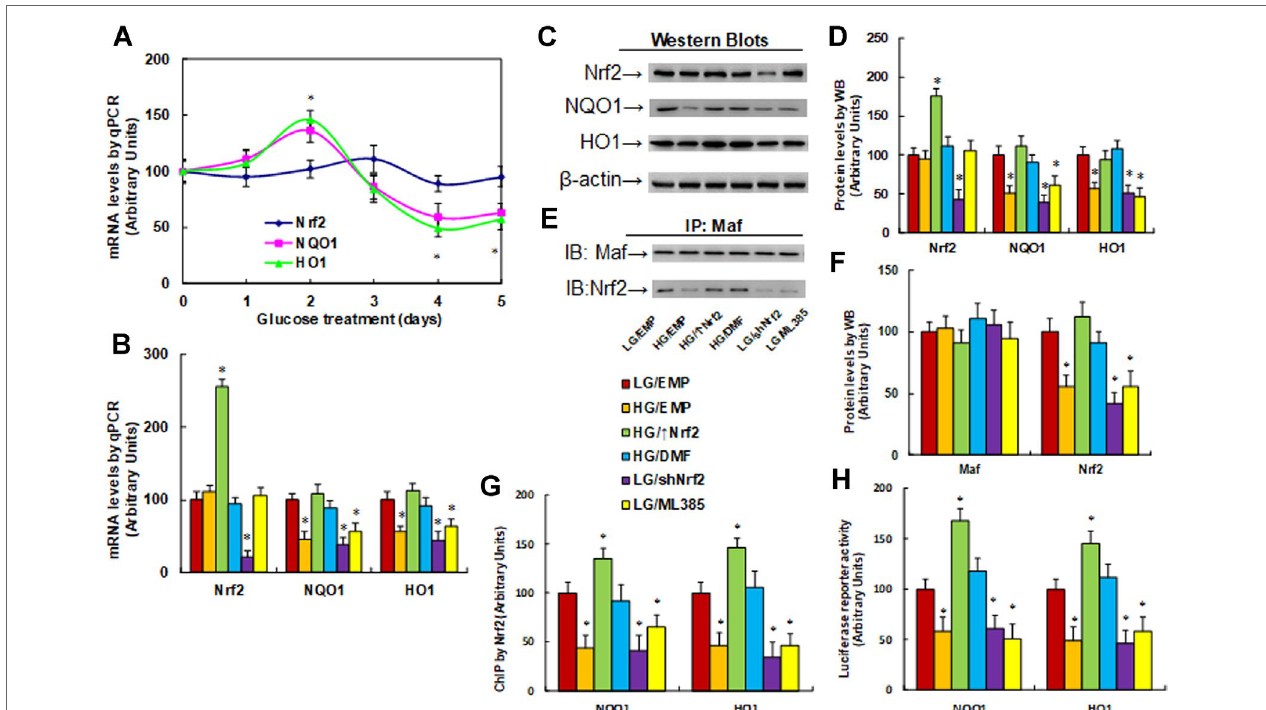
FIGURE 2 | Nrf2 activation increases, while Nrf2 suppression decreases, the expression of NQO1 and HO1. (A) Rat macrophages were incubated in hyperglycemia (25 mM glucose) continuously for 5 days in the presence of 1% FBS, and the cells were used for gene analysis, n = 4. * P < 0.05, vs day 0 group. (B–H) Rat macrophage cells were infected by an empty vector (EMP), Nrf2 lentivirus (Nrf2 ↑ ), or Nrf2 knockdown lentivirus (shNrf2) in the presence of either 5 µM Nrf2 activator DMF or 5 µM Nrf2 inhibitor ML385 (with 0.1% DMSO as vehicle), and then incubated in either low glucose (5 mM) or high glucose (25 mM glucose) continuously for 5 days in the presence of 1% FBS. The cells were harvested on day 5 for analysis. * P < 0.05, vs LG/EMP group. (B) mRNA analysis by qPCR, n = 4. (C) Representative picture for Western blots. (D) Protein quantitation for (C) , n = 5. (E) Representative pictures for IP/WB by Maf/Nrf2. (F) Protein quantitation for (E) , n = 5. (G) ChIP by Nrf2 antibody on NQO1 and HO1 promoter, n = 4. (H) Reporter activity assay for NQO1 and HO1, n = 5. Data were expressed as mean ±